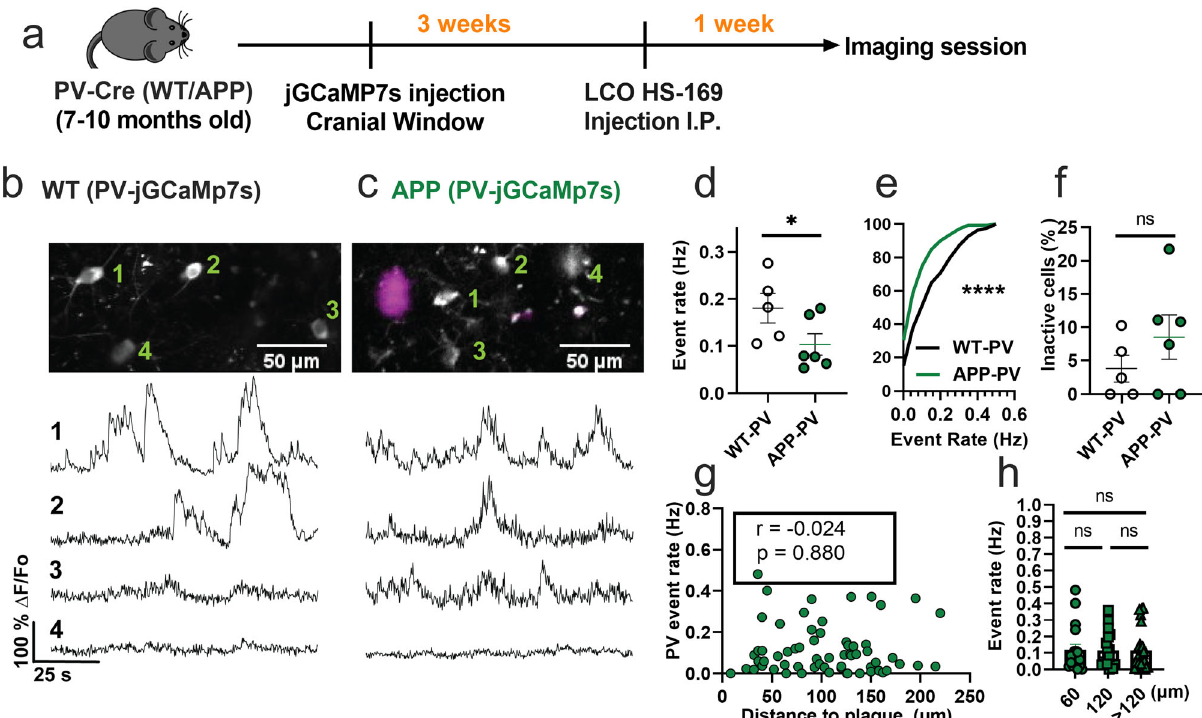
Fig. 2 PV interneurons are hypoactive in APP/PS1 mice relative to WT mice. a Timeline of the experimental procedures. b , c Top, in vivo two-photon fl uorescence images of jGCaMP7s in PV expressing interneurons (grey) in layer 2/3 of the somatosensory cortex from WT ( b ) and APP/PS1 ( c ) mice. Amyloid plaques were labeled with LCO- HS-169 (magenta); Scale bars, 50 μ m. Bottom, representative normalized fl uorescence traces from control ( b ) and APP/PS1 ( c ) mice. Representative images were created by averaging 500 images from PV interneuron recordings at 256×256 resolution with green numerical labels to the right of each representative cell. d Mean event rates (Mann – Whitney U = 4, p = 0.051, two-tailed, n = 5 WT-PV mice; 6 APP-PV mice). e Cumulative frequency distribution of event rates in all imaged neurons (KS-test:D = 0.268, p < 0.0001, n = 254 WT-PV neurons; 172 APP-PV neurons). f Quanti fi cation of the fraction of inactive cells (Mann – Whitney U = 4, p = 0.28, two-tailed) in imaged WT-PV and APP-PV (n = 5 WT mice; 6 APP/PS1 mice). g Correlations between event rates and the distance to amyloid plaque center in PV interneurons (Spearman correlation: r (63) = − 0.024, p = 0.88), and h quanti fi cation of pooled PV event rates as a function of amyloid plaque distance (Kruskal – Wallis test, H circle in d – f represents an individual animal, while each circle in g , h represents an individual neuron. All error bars re fl ect the mean ± s.e.m. Asterisks denote statistically signi fi cant differences (* p < 0.05, **** p < 0.0001), while ‘ ns ’ denotes no signi fi cance p > (Supplementary Fig. 6d). In summary, while the analysis method has a minimal effect on most of our fi ndings, PV interneuron results are limited and should be interpreted cautiously.